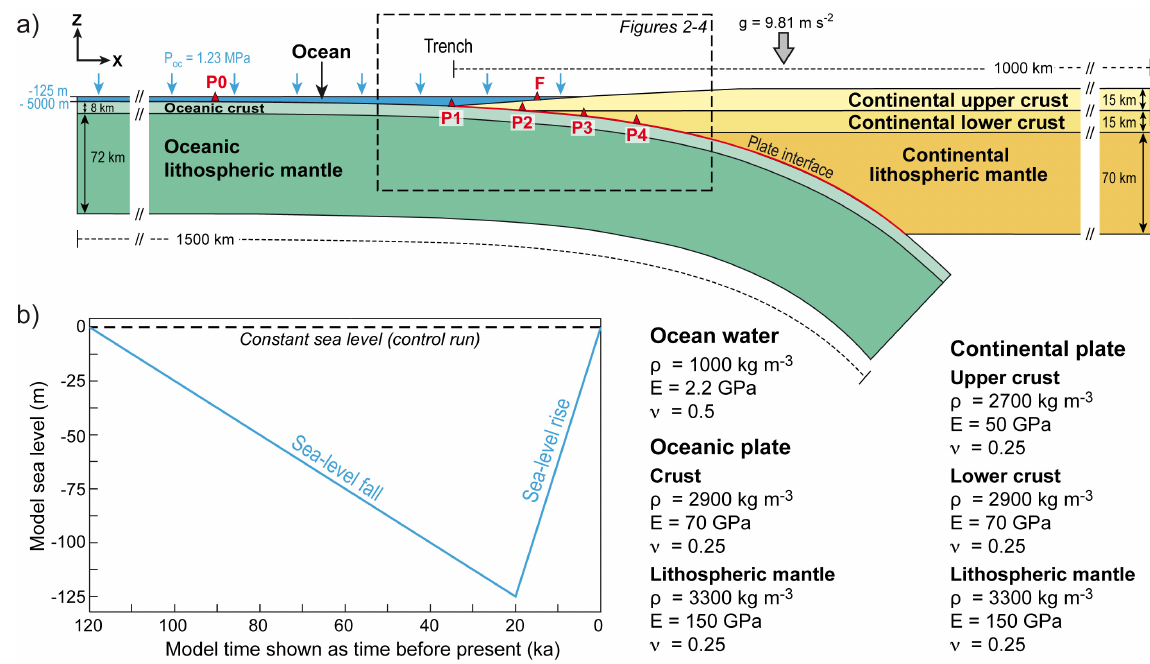
Fig. 1. (a) Setup of the finite-element model with an oceanic and a continental plate that are in contact along a locked plate interface (solid red line). Rheological parameters are ρ density, E Young’s modulus, and ν Poisson’s ratio. Gravity is included as a body force ( g acceleration of gravity). An ocean on top of the oceanic plate and the continental margin with an average water depth of 5000m is implemented as a combination of a water body (average water depth: 4875m) and a pressure P oc equivalent to 125m of water (blue arrows). This pressure is decreased and subsequently increased to simulate the falling and subsequently rising sea level during a glacial-interglacial cycle, respectively (see Fig. 1b for the temporal evolution of the pressure). At the beginning of the model run, isostatic equilibrium is established by a lithostatic pressure and elastic foundation at the bottom of the model. Afterwards, the model sides and bottom are fixed in the horizontal and vertical directions (see text for details). Red triangles mark the locations of points F and P0–P4, at which displacements and stresses were extracted from the model (Figs. 2–4, 6). Box with dashed outline marks the part of the model for which the displacement and vertical stress fields are shown in Figs. 2–4. (b) Temporal evolution of the sea level in the model, reflecting a fall and subsequent rise by 125m over 120ka (cf. Imbrie et al., 1984; Peltier and Fairbanks, 2006). For comparison, a control run was performed with a constant sea level (dashed